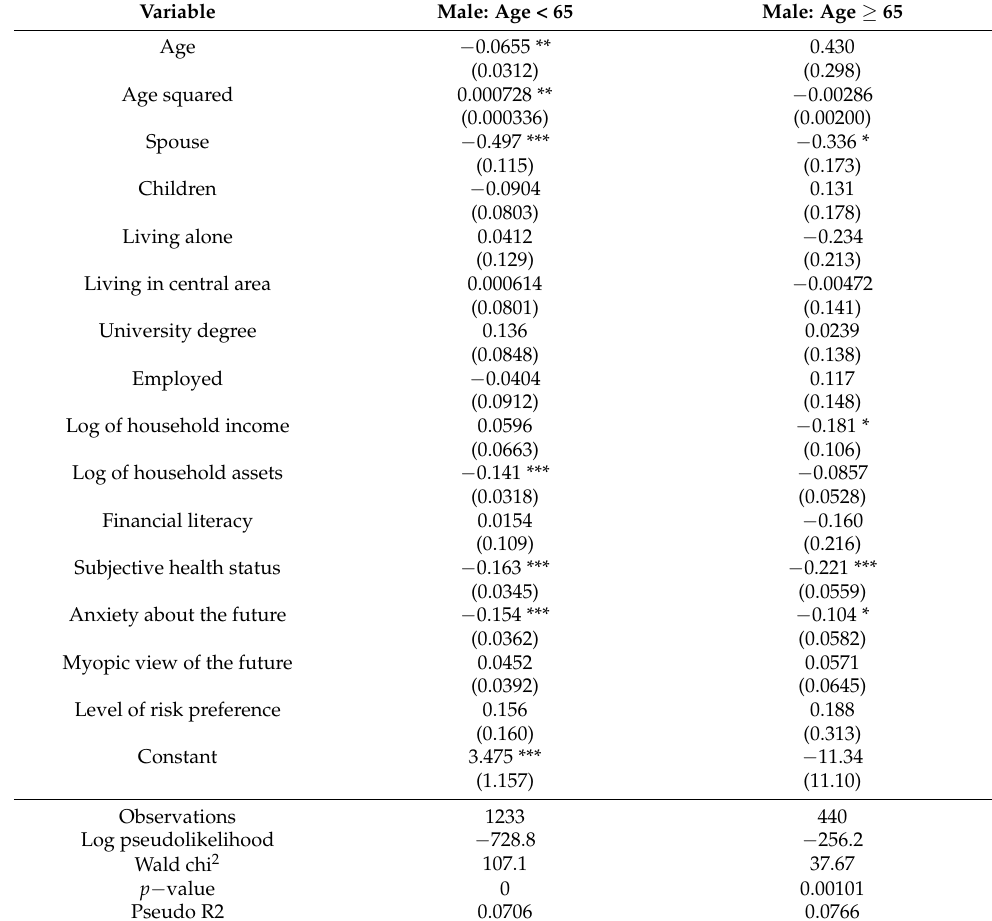
Table 6. Results of probit regression analysis regarding younger and older males’ reluctance to receive the third dose of COVID-19